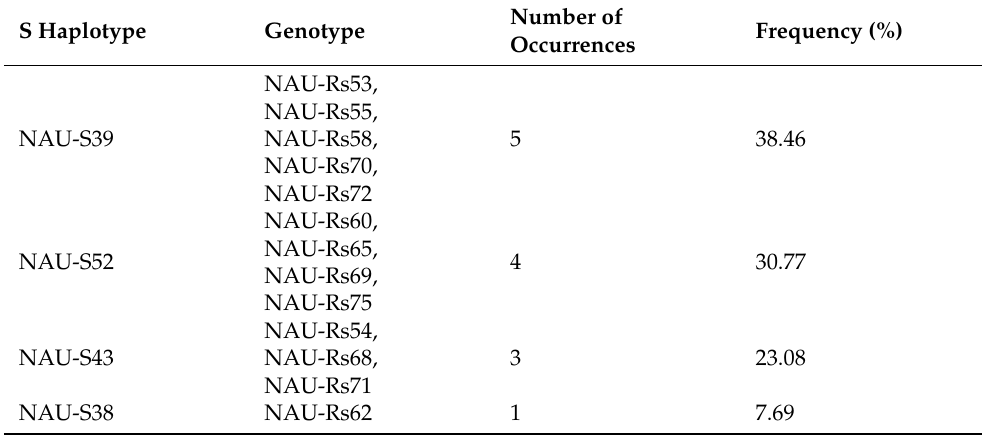
Table 4. S haplotypes frequencies among 13 Class II radish